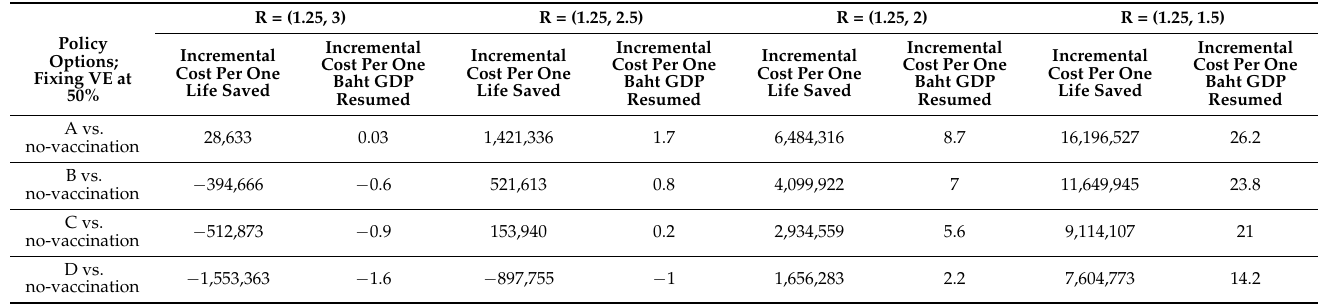
Table 7. Cost-effectiveness analysis by varying reproduction numbers.